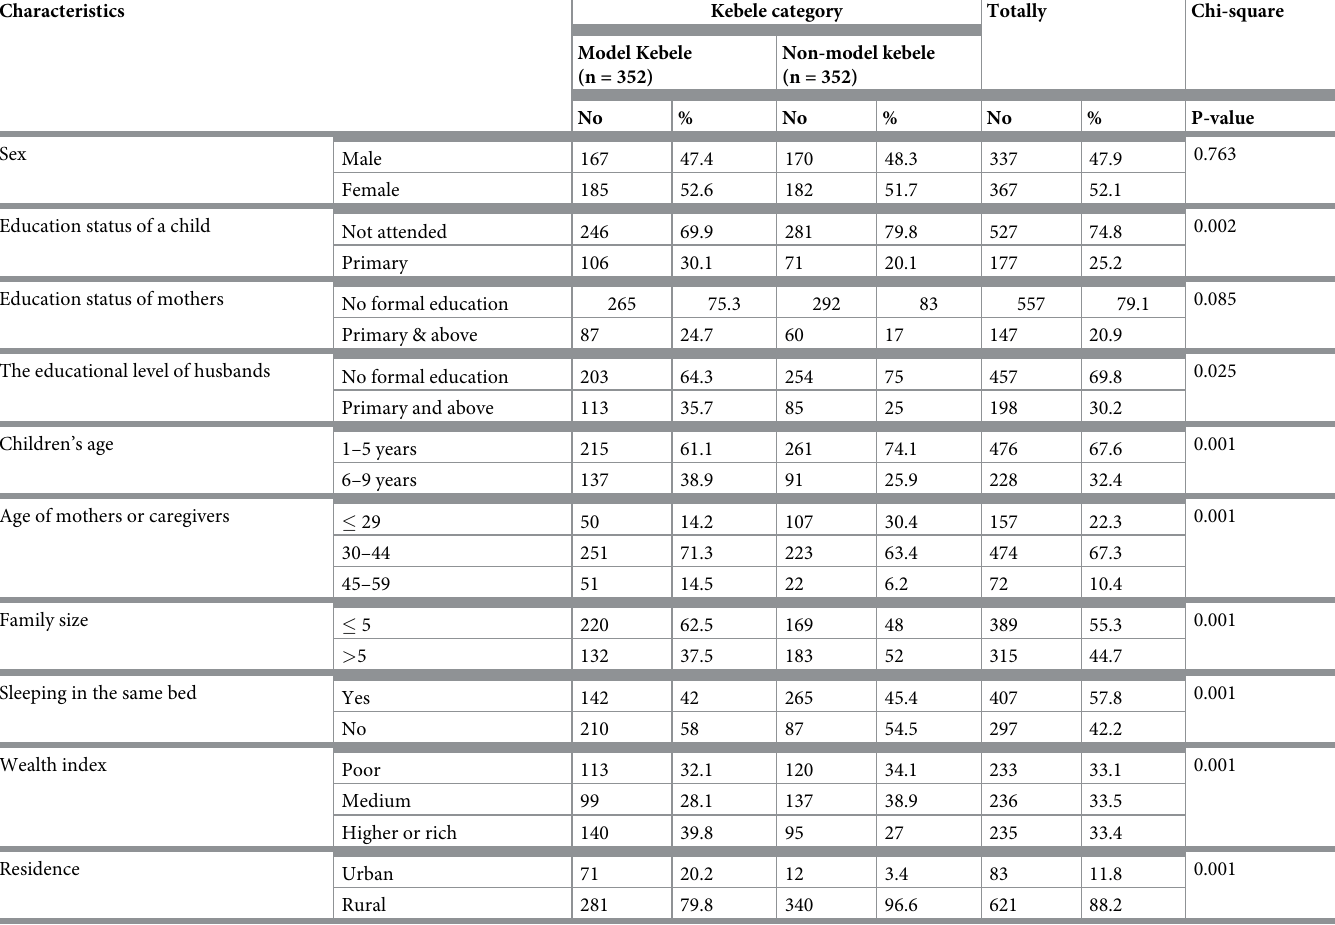
Table 1. The respondents’ socio-economic and demographic characteristics from model and non-model kebele of Dangila district, northwest Ethiopia, 2019 (n = 704). Characteristics